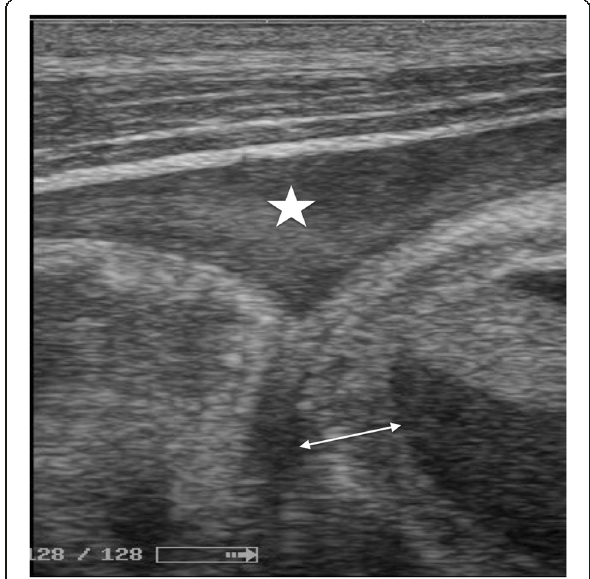
Fig. 4 Ultrasound image of a hemoperitoneum (star) in the right